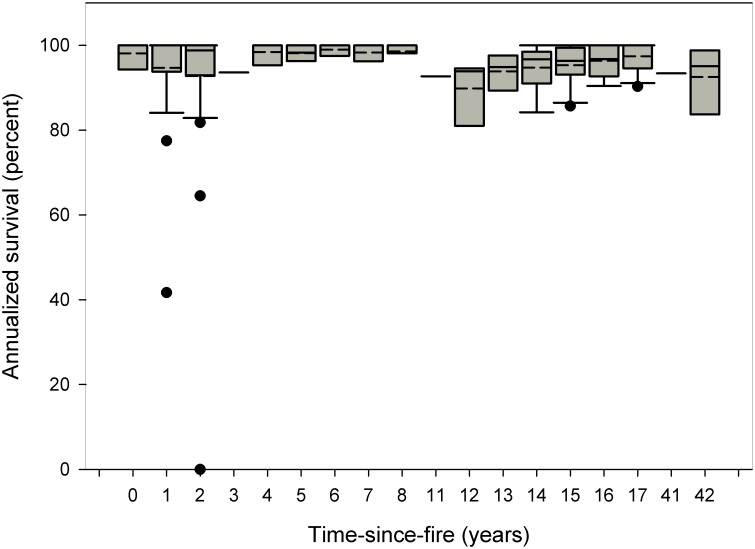
Annualized survival in relation to time-since-fire (in years) across eight subpopulations of E. rosescens for which fire history was known.Boxplots show mean (dashed line) and median (solid line). Black circles represent outliers. Sample sizes are included above each bar.